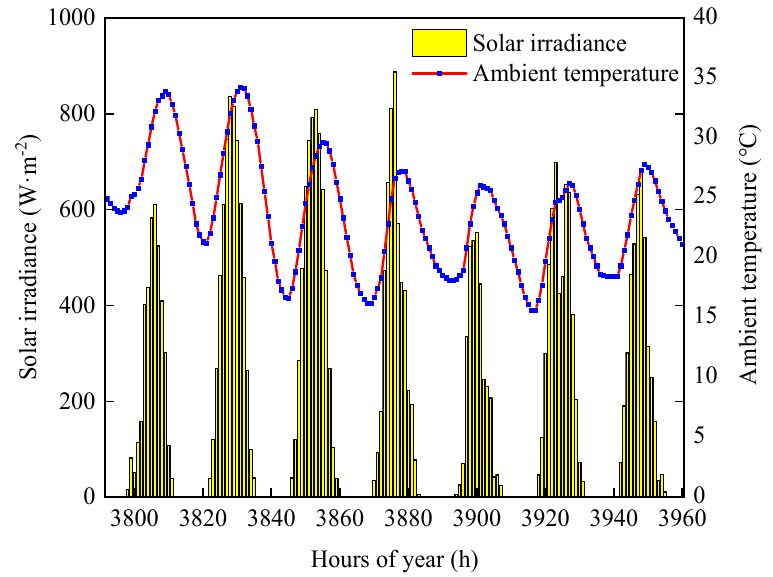
Figure 2. Data for solar irradiance and ambient temperature in Qingdao from June 8 to June 14.